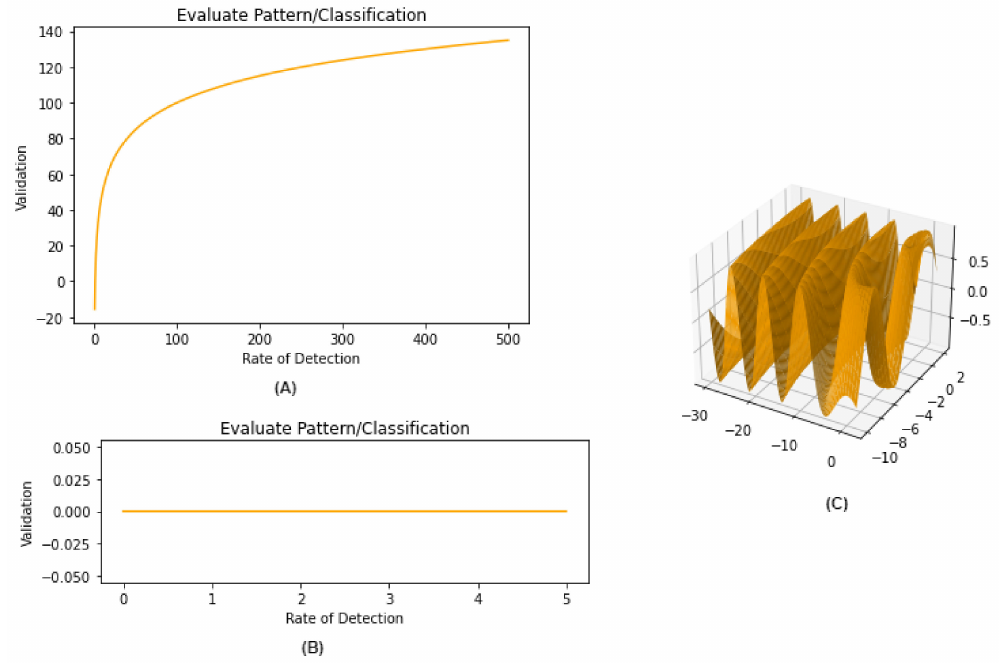
Figure 7. Rate of certificate credentials detection. ( A ) Evaluate pattern for classification, ( B ) rate of validation, and ( C ) pattern classification evaluation through a 3D